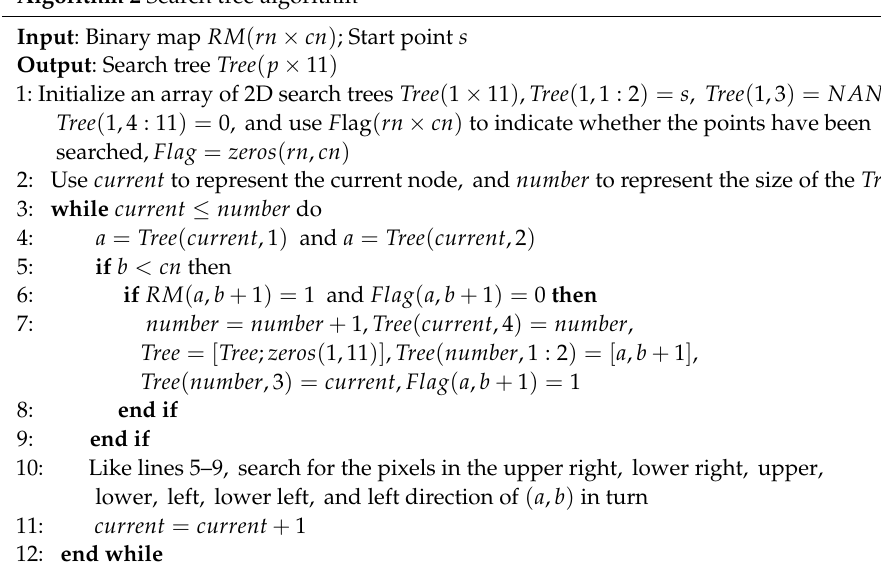
Algorithm 2 Search tree algorithm